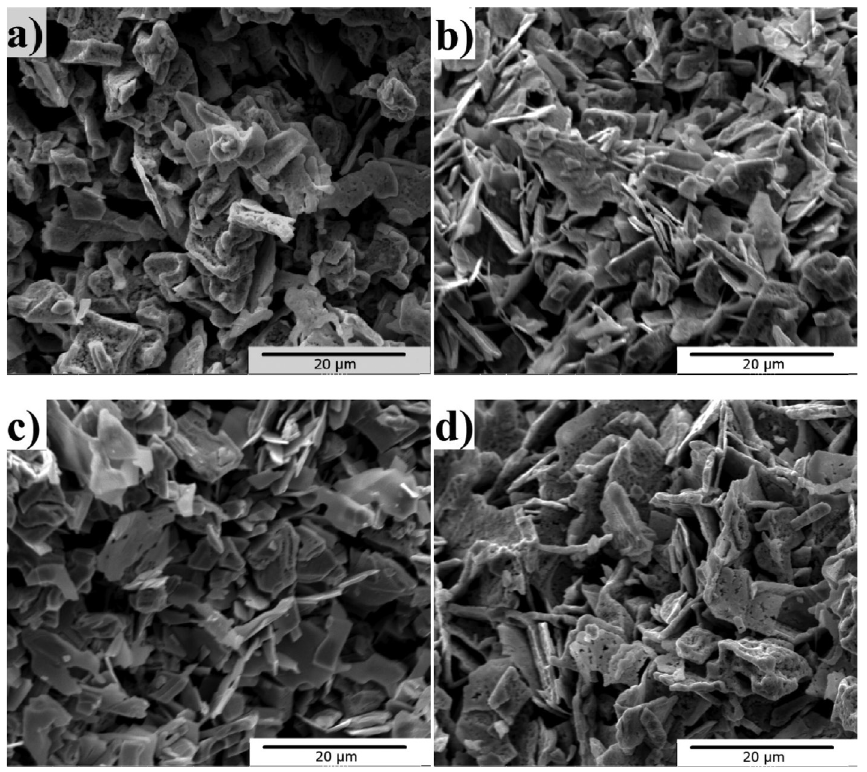
Fig. 7: Morphologies of Mo by reducing MoO 2 powders at 1123 K in H 2 -Ar: (a) 25% H 2 , (b) 50% H 2 , (c) 75% H 2 , (d) 100% H 2 (SEM